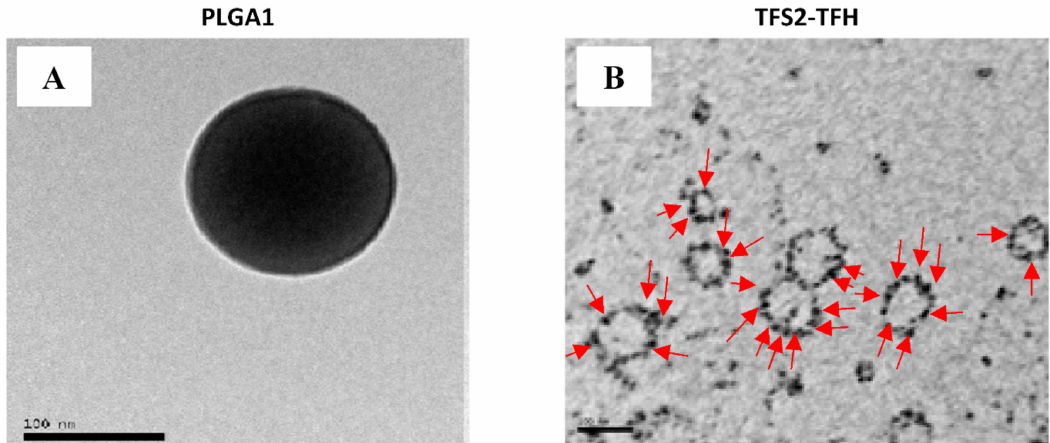
Figure 1. TEM micrographs of PLGA polymeric micelles and transfersomes containing mithramycin (MTM): ( A ) PLGA polymeric micelles prepared with Span60:Cholesterol (1:0.5)(PLGA1) by the solvent evaporation method containing MTM; ( B ) transfersomes formulated with PC:S60:20:Cho (1:1.5:1.5:1) prepared by the TFH method (TFS2-TFH) containing MTM. Red arrows indicate the presence of MTM in the membrane bilayer of transfersomes. Scale bar: 100